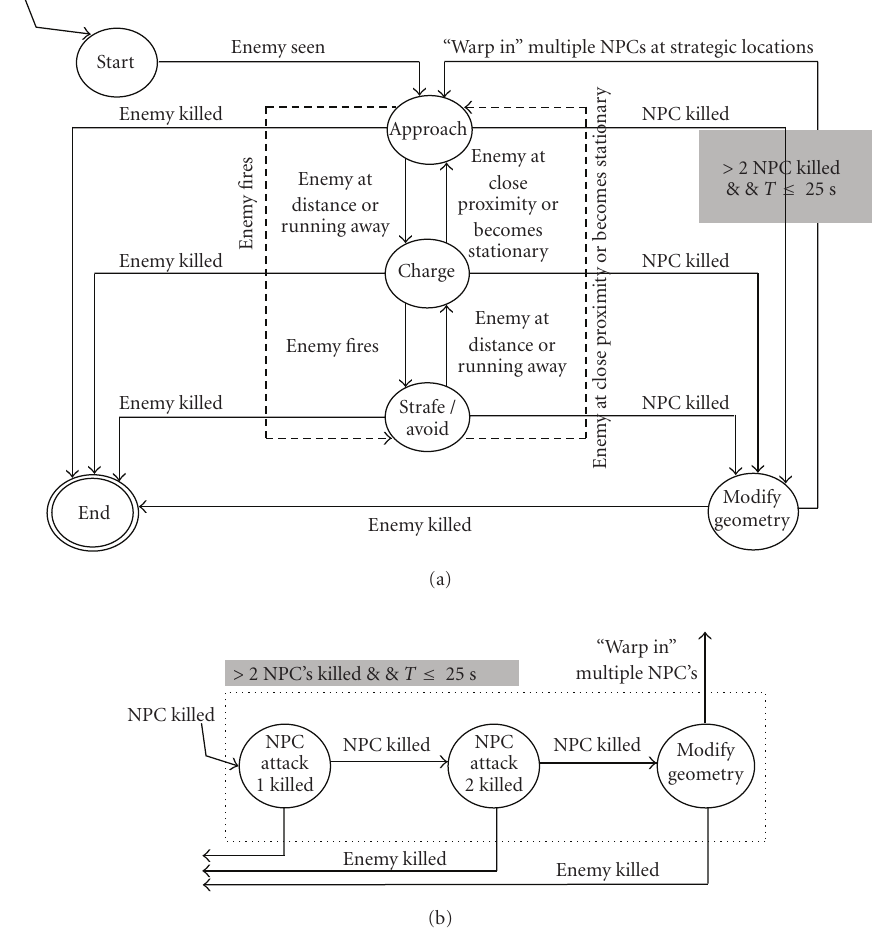
Figure 2: (a) Proposed additional “Passage Attack” finite state detailed. (b) “Modify Geometry” state detailed. movement/navigation, and position a small number of NPCs at the rear to remove the hiding places for the player and increase the di ffi culty of this